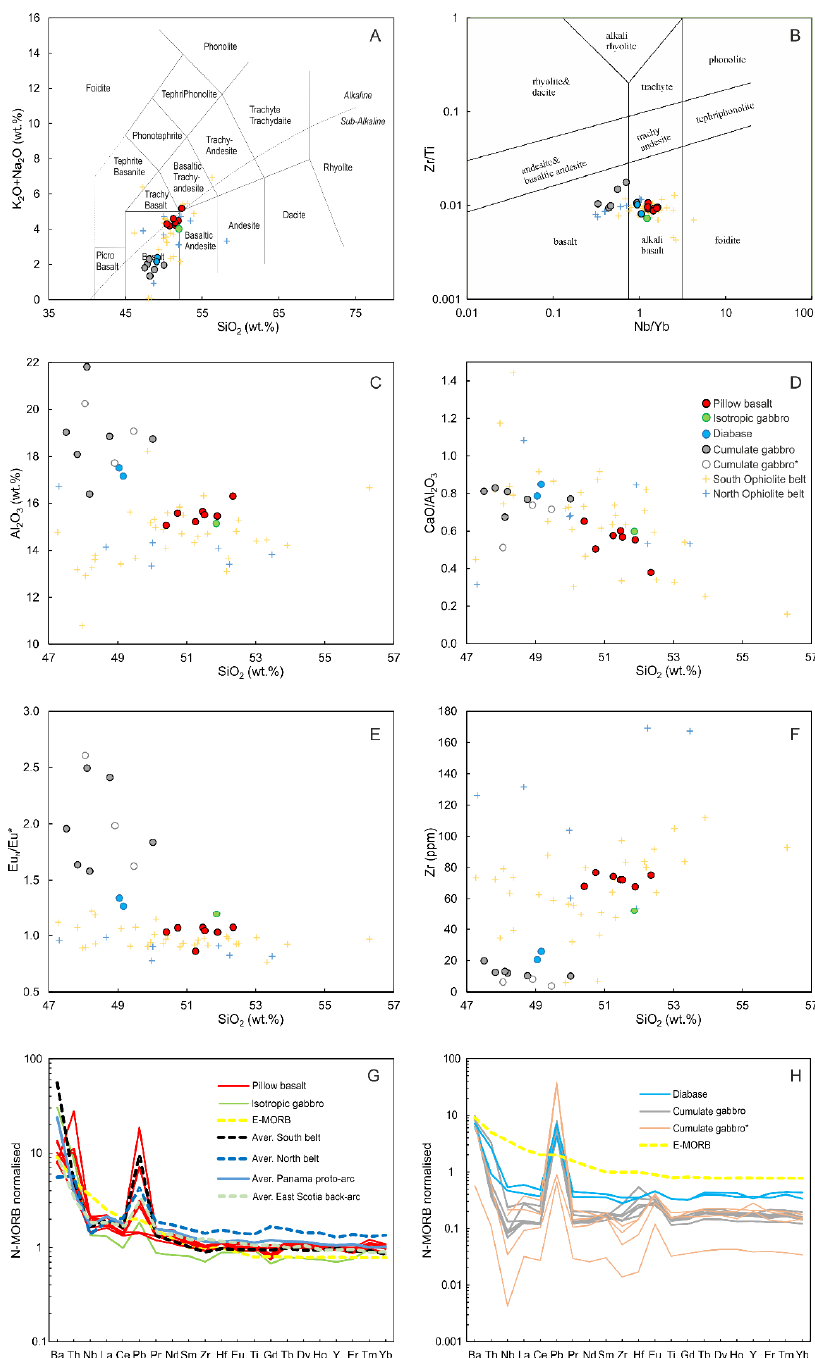
Figure 4. The plot of major and trace elements. ( A ) TAS diagram. ( B ) Nb/Yb vs. Zr/Ti discrimination diagram. ( C ) Plagioclase crystallization in SiO 2 vs. Al 2 O 3 . ( D ) Clinopyroxene crystallization in SiO 2 vs. CaO/Al 2 O 3 . ( E ) Plagioclase crystallization in SiO 2 vs. Eu N /Eu*. Eu N is chondrite normalized and Eu* = 2Eu N /(Sm N +Gd N ). ( F ) SiO 2 vs. Zr. Cumulate gabbros have lower content of the incompatible trace element Zr than pillow basalts and isotropic gabbros. ( G ) N-MORB normalized multi-element diagram for pillow basalts and isotropic gabbros. ( H ) N-MORB normalized multi-element diagram for cumulate gabbros. Mafic rocks in South Ophiolite Belt are from [31,33,36–38,54]. Mafic rocks in North Ophiolite Belts are from [45]. Cumulate gabbro* in Yushigou and Dongcaohe are from [33] and [38] respectively. Panama proto-arc rocks are from [15]. E-MORB is from [55]. East Scotia back-arc basalts are from GEOROC database (accessed in October